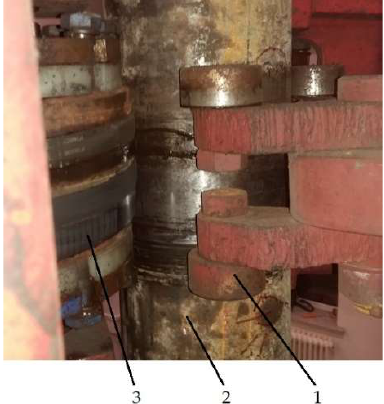
Figure 9. Physical photo. In the figure: 1—follow-up roller, 2—drill pipe, 3—driving roller.